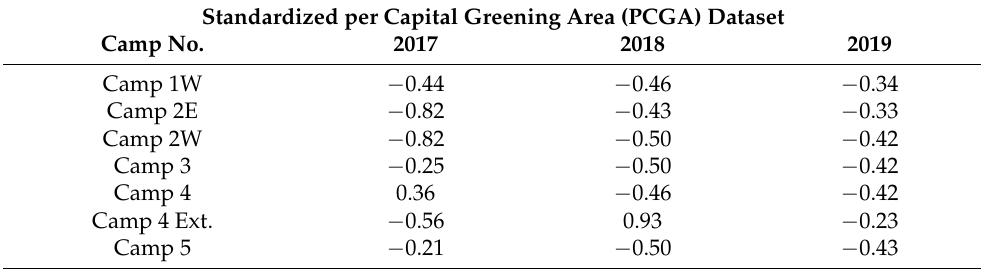
Table A2. Standardized value of Per Capital Greening Area (PCGA) dataset in 2017, 2018, and 2019, by the period of